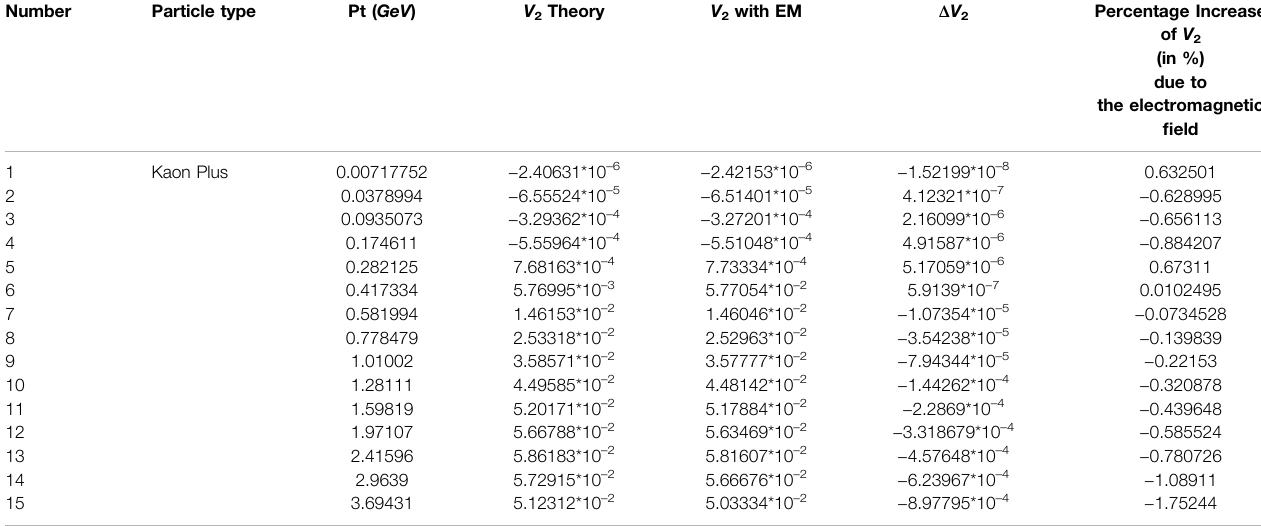
TABLE 3 | The percentage increase of elliptic fl ow of Kaon-Plus due to the electromagnetic force evolution created in relativistic Pb + Pb collision with collision energy of (cid:4) √ (cid:1) 2.76 ATeV at centrality ranging from 20to30%(impactparametersinthe range 6.24 fm < b < 9.05 fm). The changein elliptic fl ow ( Δ V s V 2 Theory and V 2 with